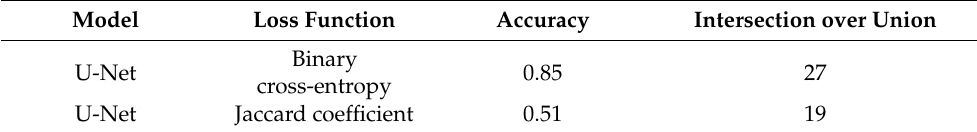
Table 1. U-net model performance comparison for two loss functions.